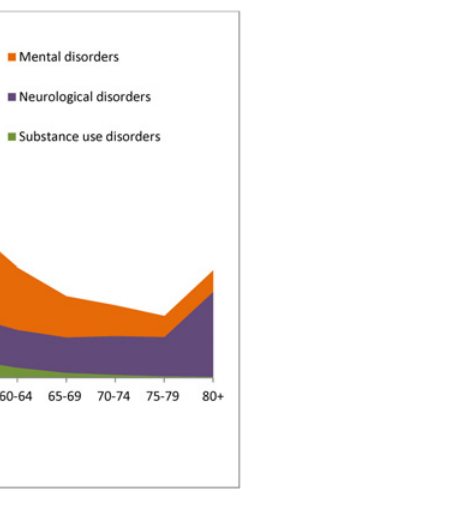
Fig 1. Absolute DALYs Attributable to Mental, Neurological, and Substance Use Disorders, by Age,